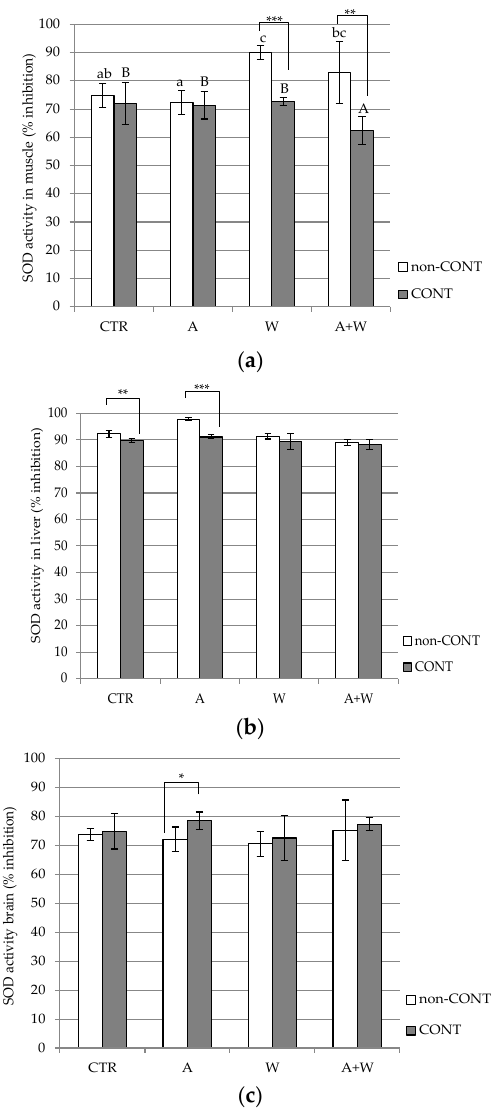
Figure 3. Superoxide dismutase (SOD) activity (percentage inhibition, mean ± SD) in S. senegalensis muscle ( a ), liver ( b ), and brain ( c ) after 28 days of Hg exposure. White bars represent non-contaminated treatments (non-CONT) and gray bars represent Hg-contaminated treatments (CONT). CTR—seawater temperature set at 19 °C and pH set at 8.0 units; A—seawater temperature set at 19 °C and pH set at 7.6 units; W—seawater temperature set at 23 °C and pH set at 8.0 units; A + W—seawater temperature set at 23 °C and pH set at 7.6 units. Different small letters denote significant differences between non-CONT treatments (ANOVA, p < 0.05). Different capital letters denote significant differences between CONT treatments (ANOVA, p < 0.05). Asterisks (*) represent differences between non-CONT and CONT for the same conditions (Student’s t -test: * p < 0.05; ** p < 0.005; *** p < 0.0005).